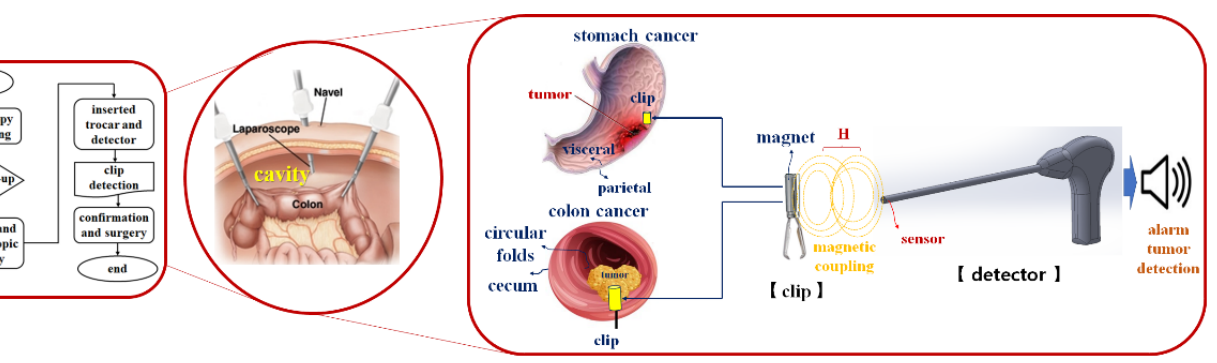
sensor is attached to the end of the detector.